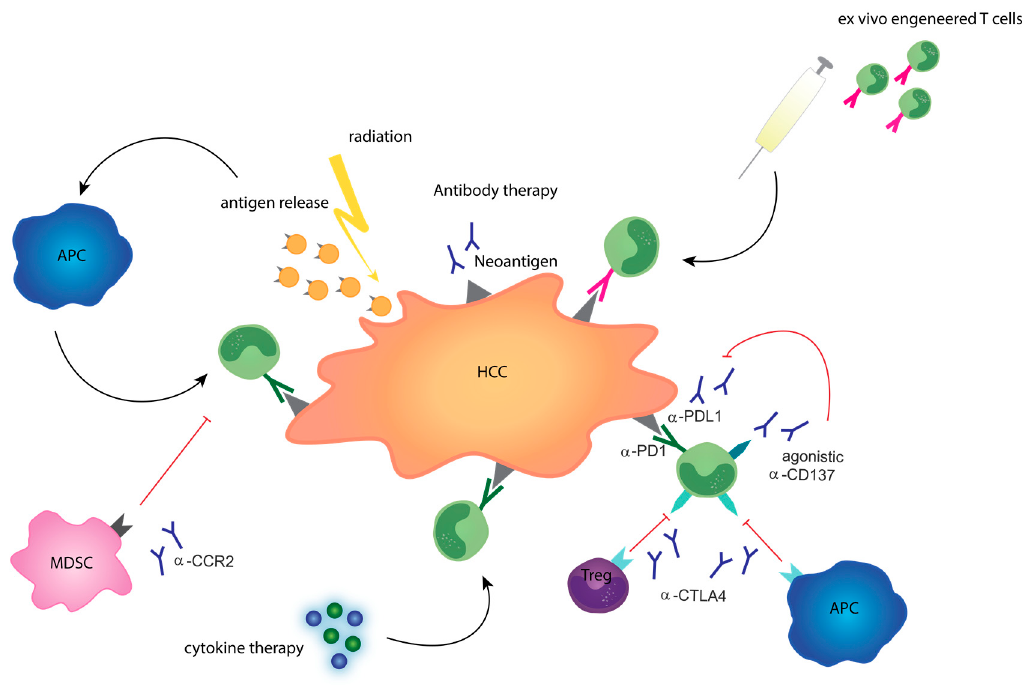
Figure 1. Overview of therapeutic approaches in immunotherapy. Targeted antibody therapy can block inhibitory signals, e.g., CTLA-4 or PD-1 and “unleash” anti-tumor immunity or block immunosuppressive mechanisms of the adaptive as well as the innate immune system. Besides a direct anti tumoral e ff ect, irradiation leads to an antigen release that promotes antigen presentation by APCs and enhances anti-tumoral T cell response. Cytokine therapy is an option to enhance a general T cell response in the tumor. Ex-vivo engineered T cells or antibodies against tumor specific neoantigens induce a targeted anti-tumor response. Abbreviations: Myeloid derived suppressor cell (MDSC), antigen presenting cell (APC), regulatory T cell (Treg), cytotoxic T lymphocyte antigen 4 (CTLA4), programmed death protein (PD1), programmed death ligand 1 (PDL1).